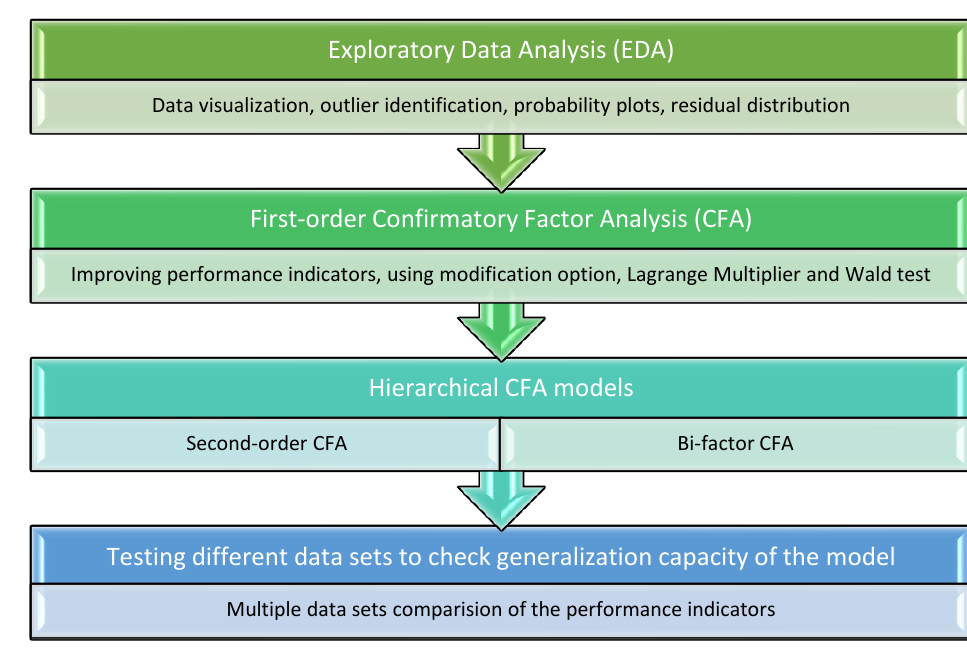
Figure 1. Research methodology.